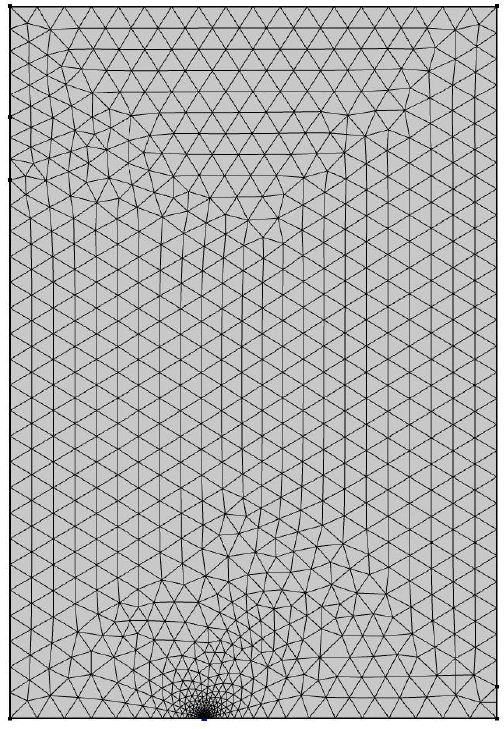
Figure 5. The symmetry of the FE model of the cracked plate.